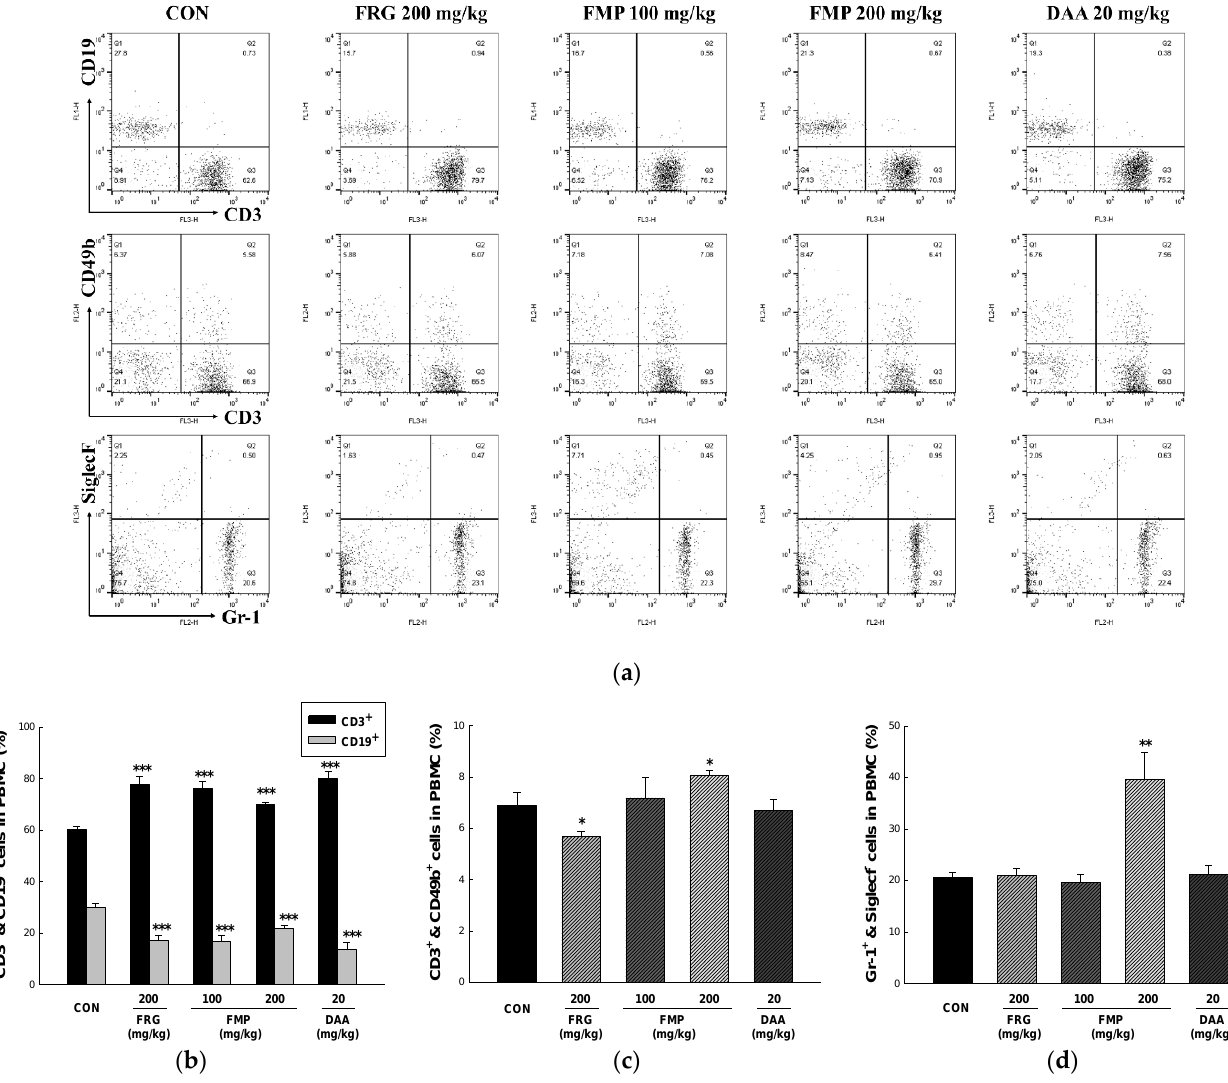
Figure 5. Effects of FMP on cell number in peripheral blood mononuclear cells of Balb/c mice. ( a ) Dot plot of representative fluorescence-activated cell sorting analysis of PBMCs and percentage of ( b ) CD3 + and CD19 + , ( c ) CD3 + and CD49b + , ( d ) Gr-1 and SiglecF - were determined using FACS Calibur two-color flow cytometer. All values are expressed as the mean ± standard error. * p < 0.05, ** p < 0.01 and *** p < 0.001 vs. no treatment group. FRG, fermented red ginseng extract; FMP, fermented M. citrifolia polysaccharide; DAA, deacetylasperulosidic acid.